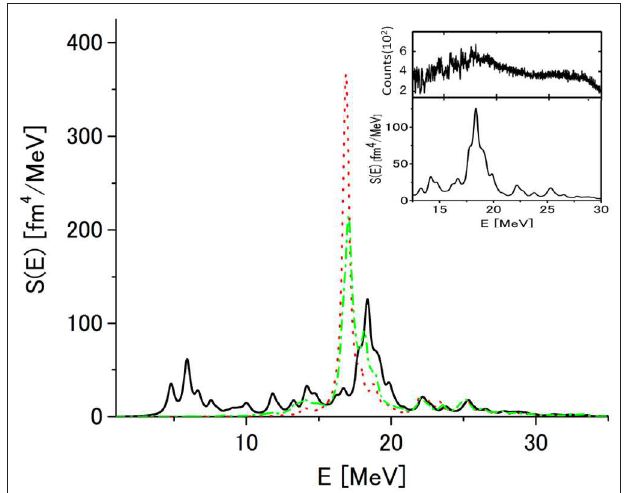
FIGURE 10 | Strength functions calculated in RPA (dotted line), SRPA (dot-dashed line) and ERPA (solid line) for the isoscalor quadrupole excitation in 40 Ca. The distributions are smoothed with an artificial width Ŵ the inset the ERPA strength distribution (lower part) is compared with the experimental data from ( p , p ′ ) experiments at E p [ 59] (upper part). Redapted from Tohyama [36] under the Creative Commons CCBY license.